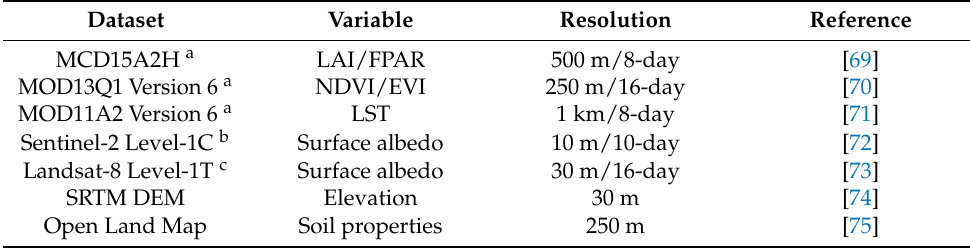
Table 1. Description of multiple datasets used in this